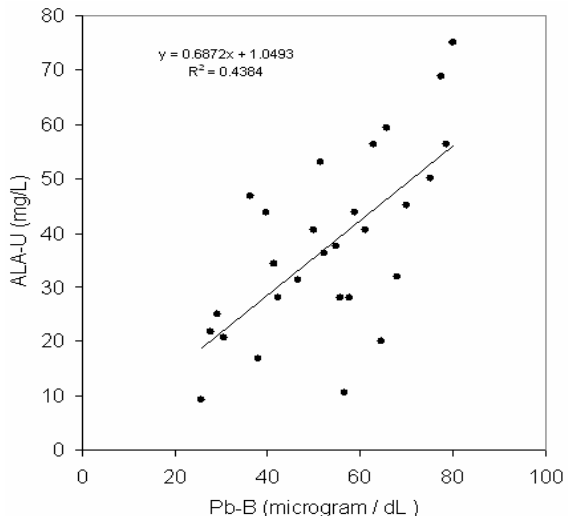
Figure 2: Relationship between blood lead concentration (Pb-B; range is 25.8 – 78.5 µg/dl) and d- aminolevulinic acid in urine (ALA-U) of lead exposed battery manufacturing workers (BMW) group of western Maharashtra (India); n = 28, Correlation coefficient (r)